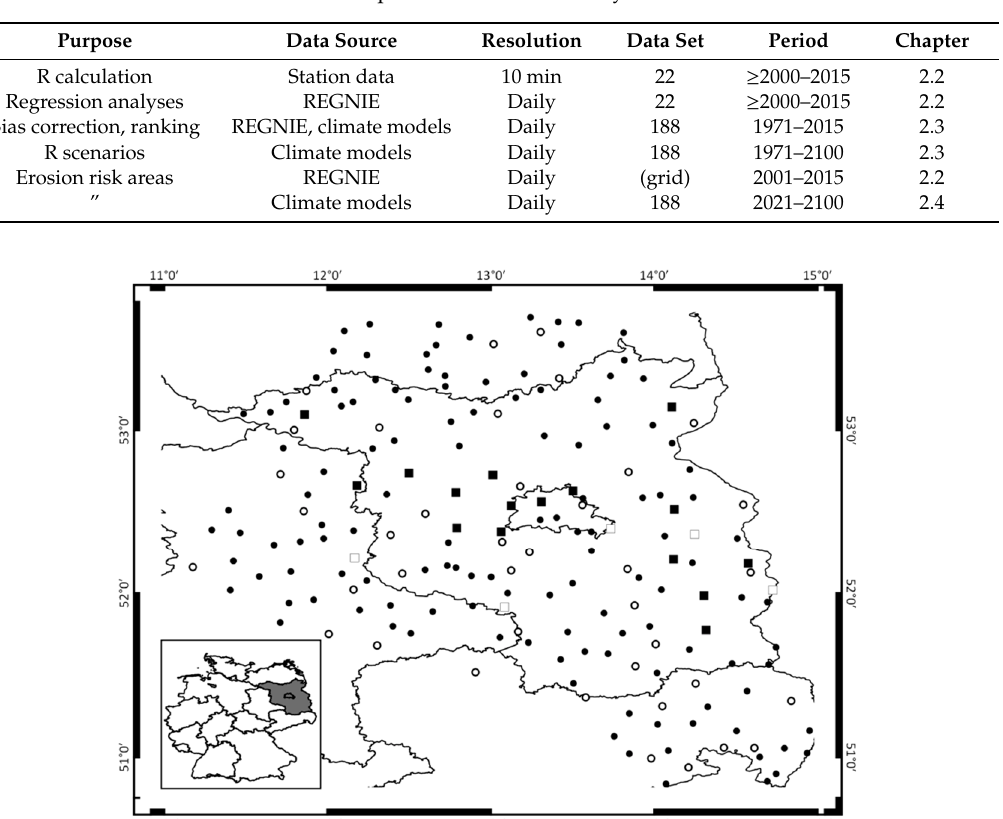
Figure 1. Climate stations used in this study and location of the study area in Germany (inset map), squares: stations with 10 min data for R calculation (Table 1), all stations with daily data to estimate R factors, bias correction of the climate models, and scenario analyses, black: stations with data for 1971–2015, hollow: stations with shorter time series. To harmonize the time series and to fill gaps we extracted the time series from regionalized station data.